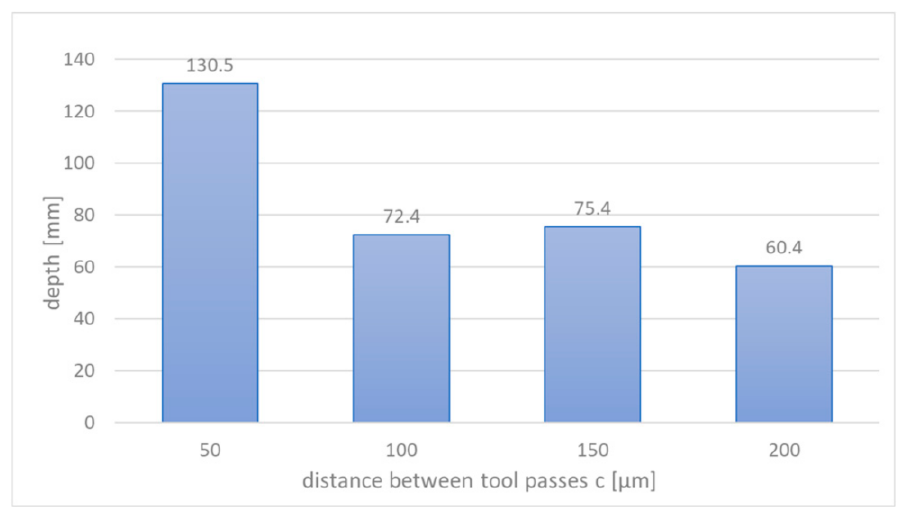
Figure 18. Changes of depth of the cavity with the distance between passes of the electrode tool c